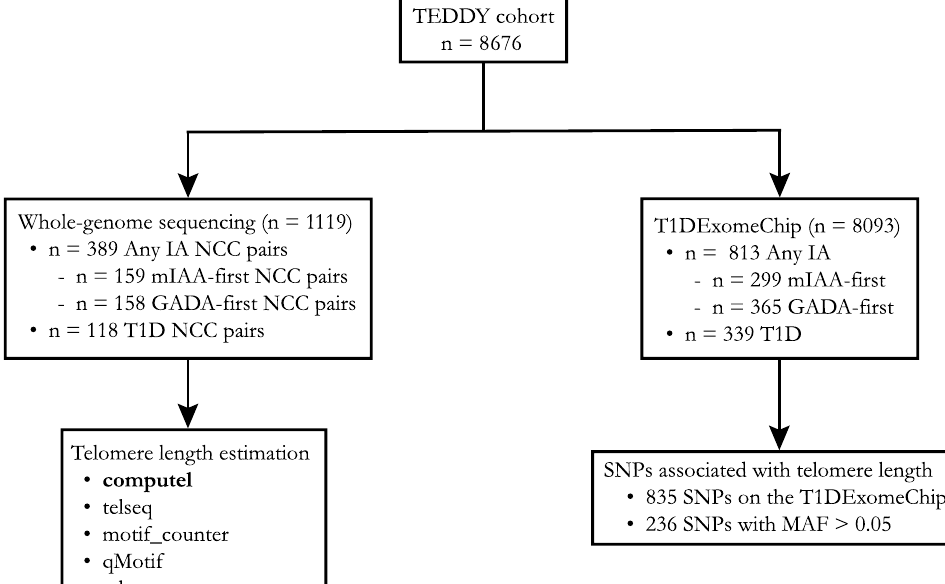
Figure 1. Whole-genome sequencing (WGS) was performed on the subjects in the nested case–control (NCC) study for islet autoimmunity (IA) and type 1 diabetes (T1D). In the NCC study, the “cases” were those subjects that had developed any IA (n = 389) or T1D (n = 118) and “controls” were randomly selected from those autoantibody-negative or non-T1D children in the index case’s risk set, matched for sex, clinical site and first-degree relative (FDR) status. Telomere length estimation was performed using five different tools. Single nucleotide polymorphisms (SNPs) were genotyped using the T1DExomeChip array. A total of 835 SNPs associated with telomere length were available on the T1DExomeChip and 236 of those had a minor allele frequency (MAF) > 0.05. SNP analysis was performed on 8093 TEDDY